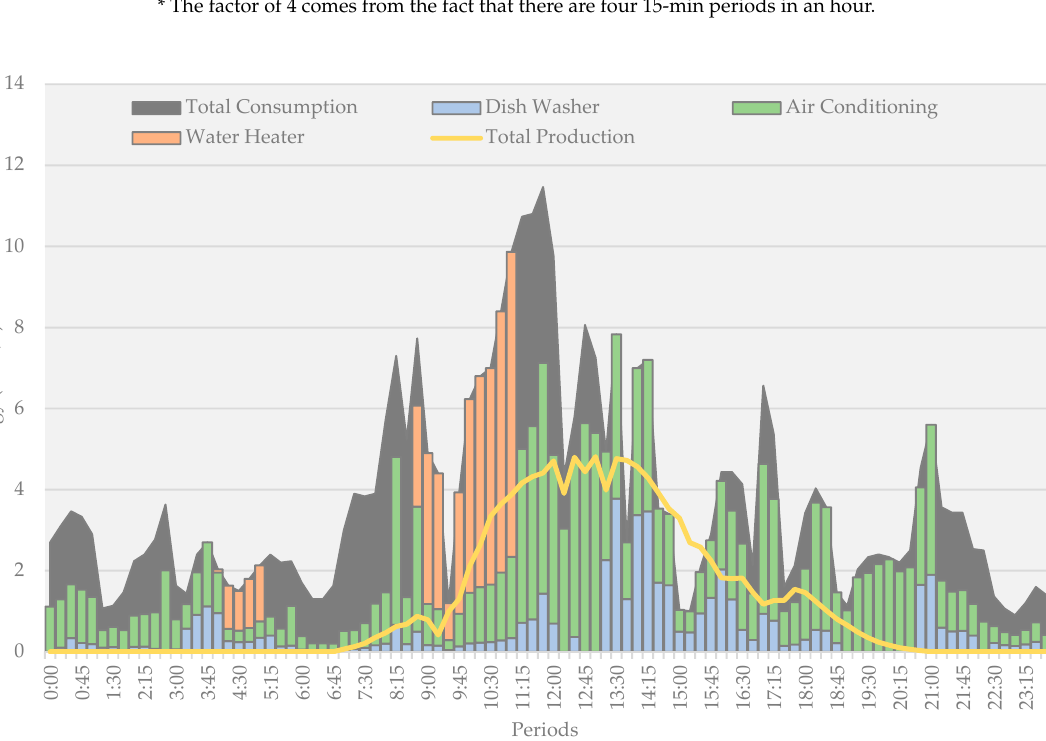
Table 3. Particle swarm optimization (PSO) parameters used.